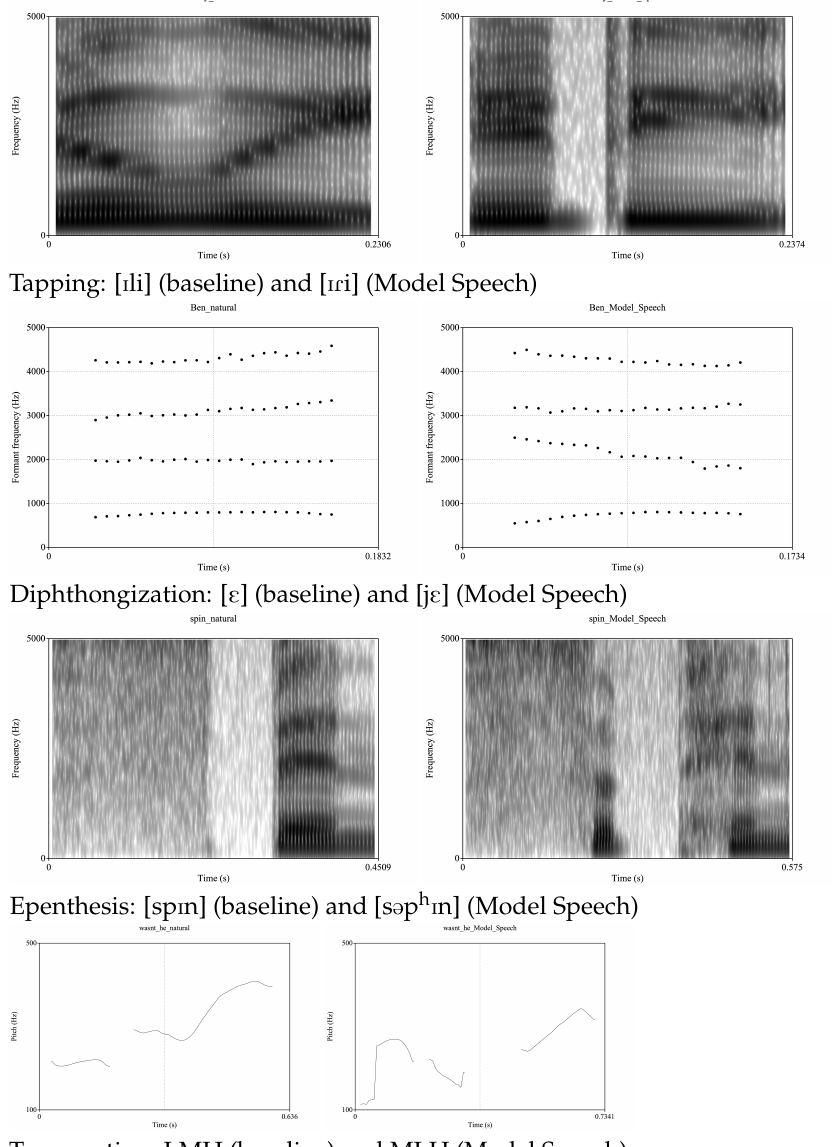
Figure 2. Examples of the 4 features in baseline ( left ) and Model Speech ( right ). The VCV sequence for tapping was extracted from the word ‘chilly’. The tracks of formants 1–4 are obtained from the vowel in the word ‘Ben’. The spectrograms for epenthesis are obtained from the word ‘spinning’. Pitch tracks for the sequence ‘wasn’t he?’ illustrate the intonation change